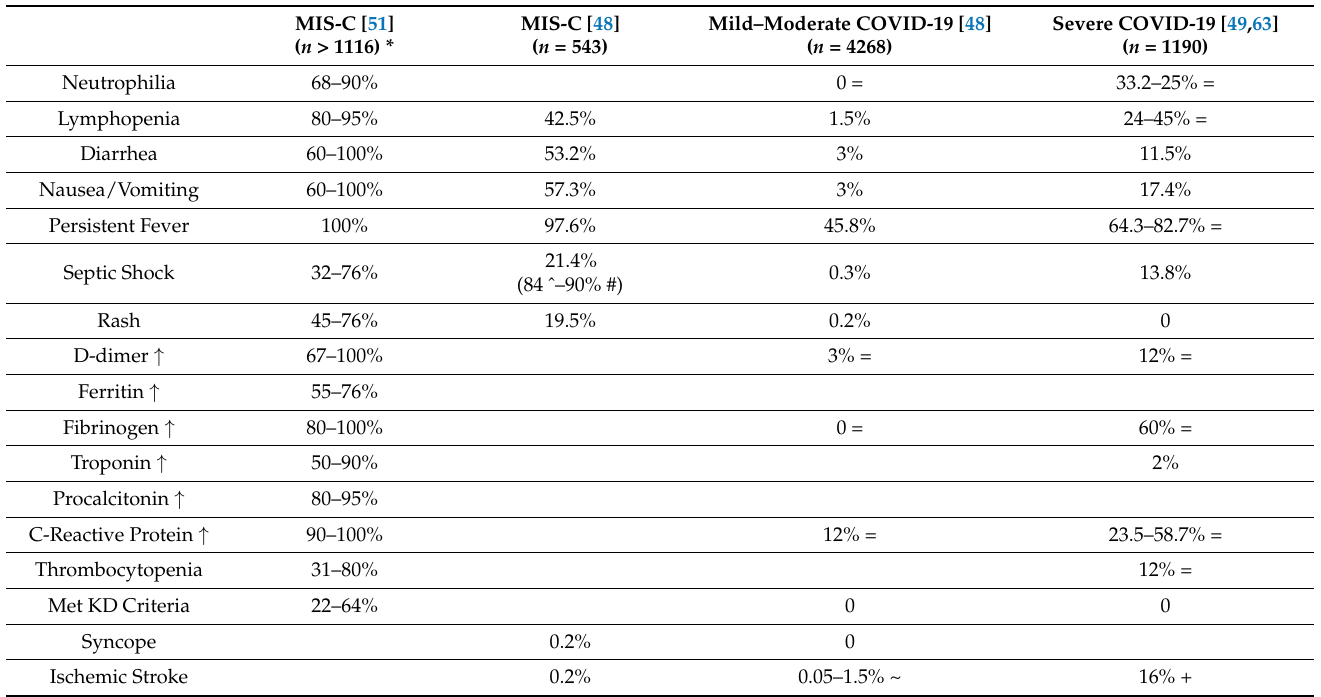
Table 1. Comparison of various immunological markers in MIS-C patients with mild-to-moderate COVID-19 and severe COVID-19 patients, demonstrating that MIS-C patients have even greater increased inflammation than the average severe COVID-19 patient. * The Son et al. review [51] included multiple reviews that appear to have used some overlapping data sets; the largest re- ported 1116 patients; if there was no overlap, the total of all the studies would approach 4000 cases. ˆ Garcia-Salido et al. [63] reported that 84% of MIS-C cases had septic shock. # Davies et al. [64] ( n = 78 patients) reported that up to 90% of their British PIMS cases experienced septic shock. ~ Quereshi et al. [65] ( n = 8163 patients) found a higher rate of stroke than did Kornitzer et al. [48]. + Smilowitz et al. [66]. = Fu et al. [67] ( n = 75 patients). KD = Kawasaki